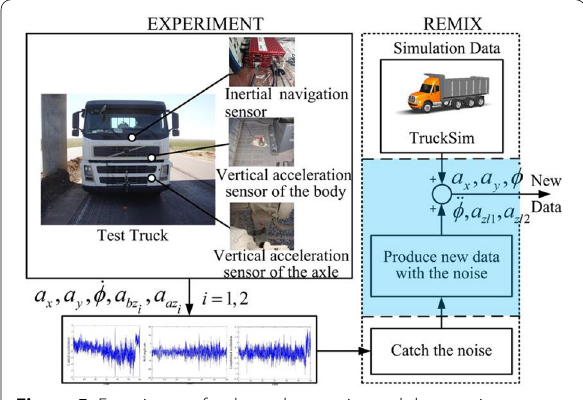
Figure 5 Experiments for the real test noise and data